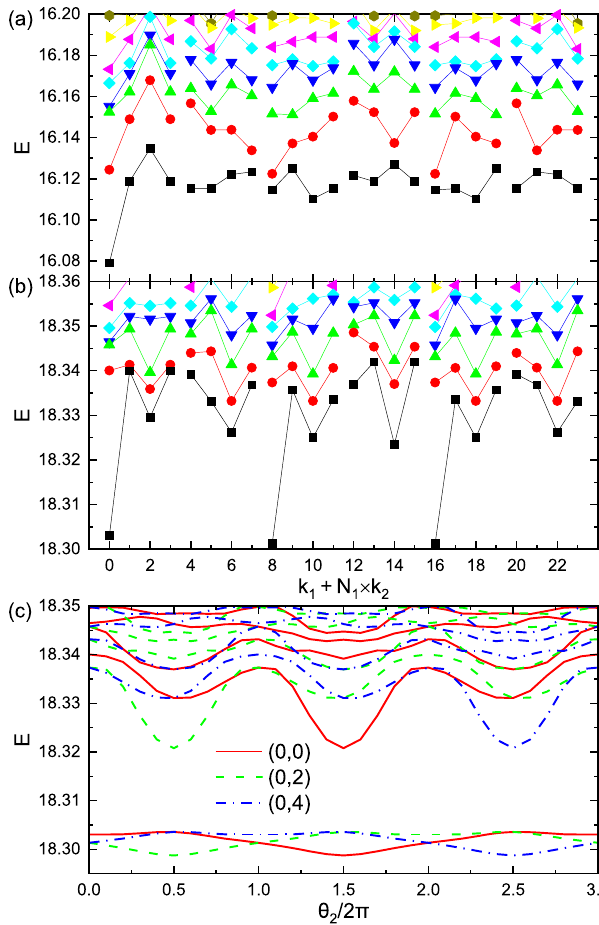
Fig. 4 Emergence of a ν = 1/3 fractional Chern insulating state. Low- energy spectra of an interacting model with t δ = 0.5 with r 2 = 0 (a) and r = − 0.2 b Other parameter values are λ = 0.2, U = 2 (local Coulomb 2 interaction), and V = 1 (nearest-neighbor Coulomb interaction). Ground state energy is indicated by black squares, and excited state energies are indicated by different symbols. c Spectral fl ow of the ground state manifold upon fl ux insertion with t δ = 0.5 with r 2 = − 0.2. Red solid lines, green dashed lines, and blue dash-dotted lines are for sector ( k 1 , k 2 ) = (0, 0), (0, 2), and (0, 4),